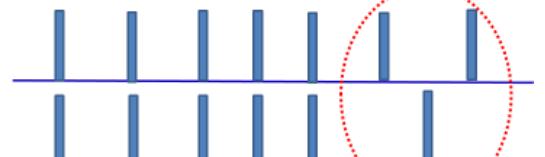
Figure 8. Competition of two cortical areas with different degrees of